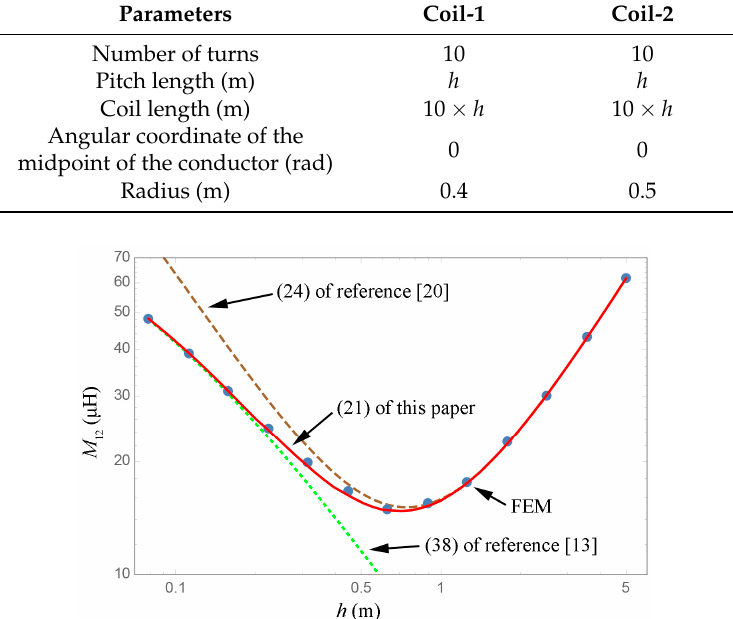
Figure 8. Pitch length ( h ) dependence of the mutual inductance (